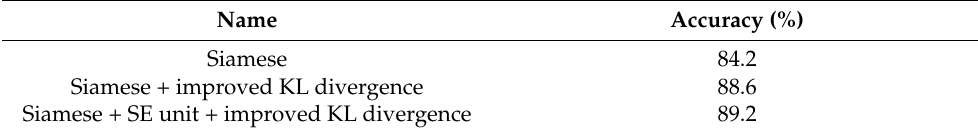
Table 3. Result of different